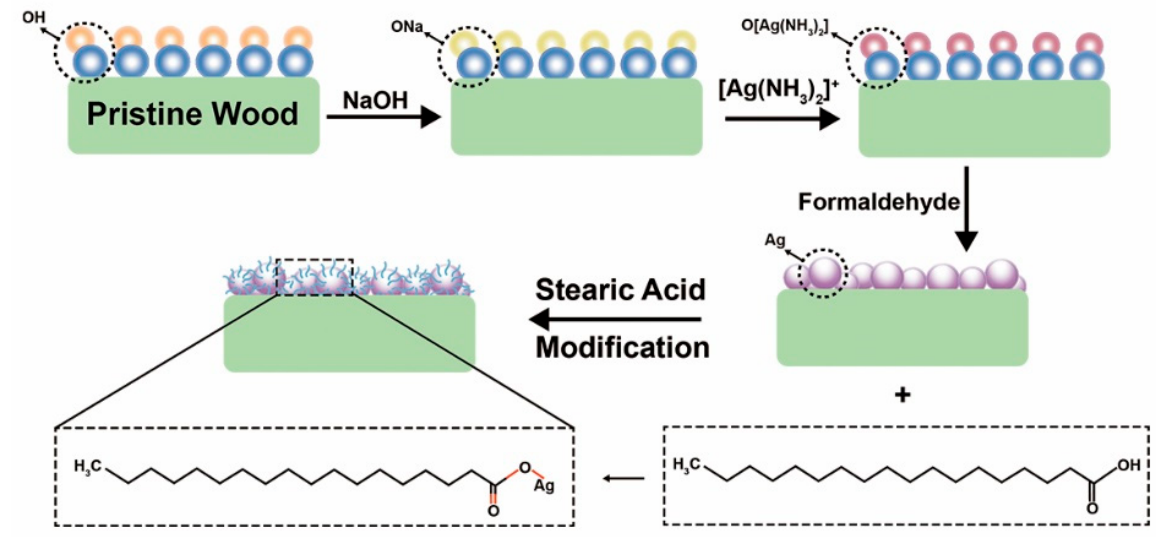
Figure 3. The modification mechanism of wood@Ag@SA.